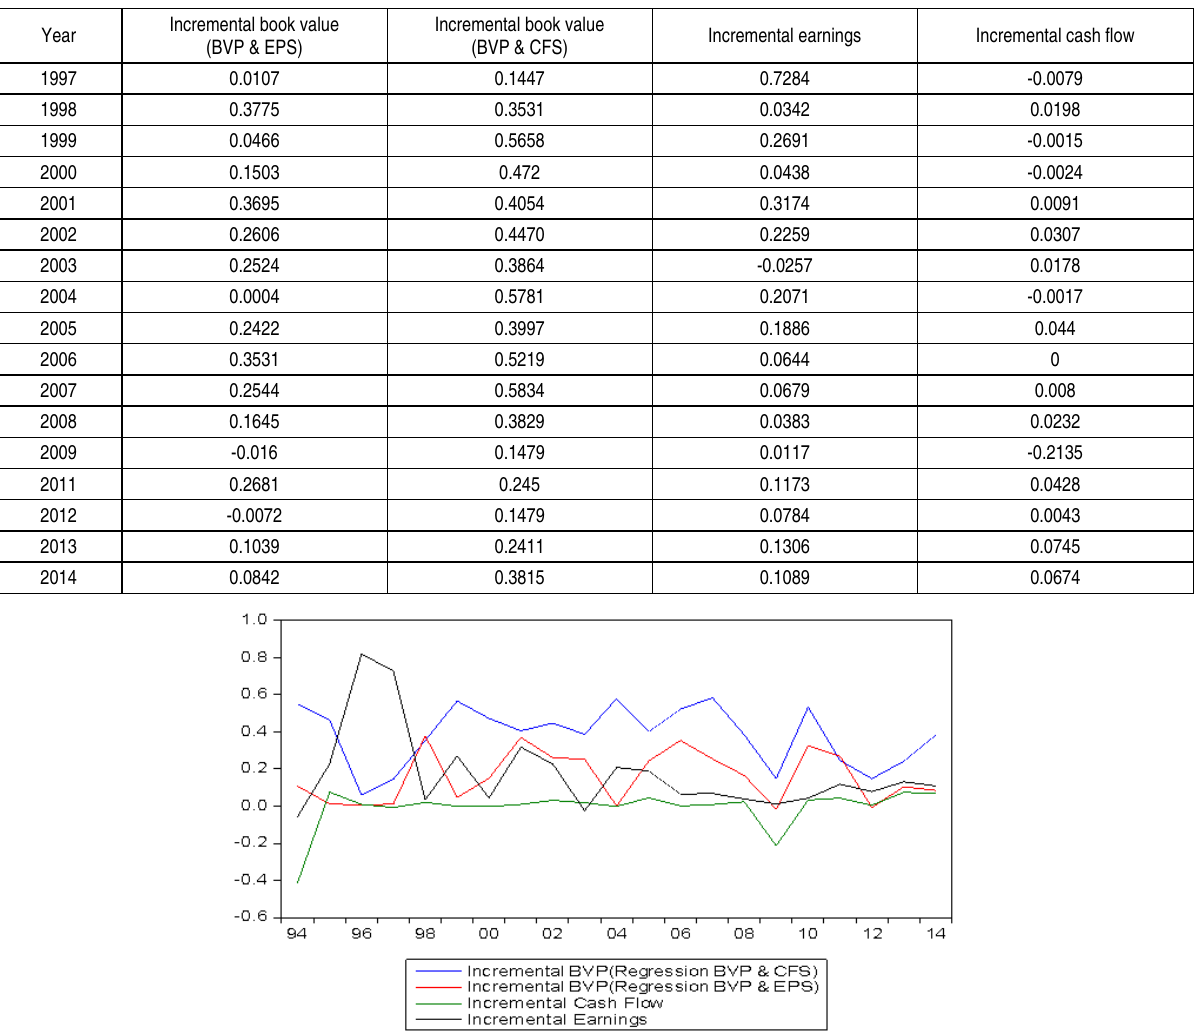
Table 6 (cont.). Analyses of the incremental information content of book values, cash flows and earnings